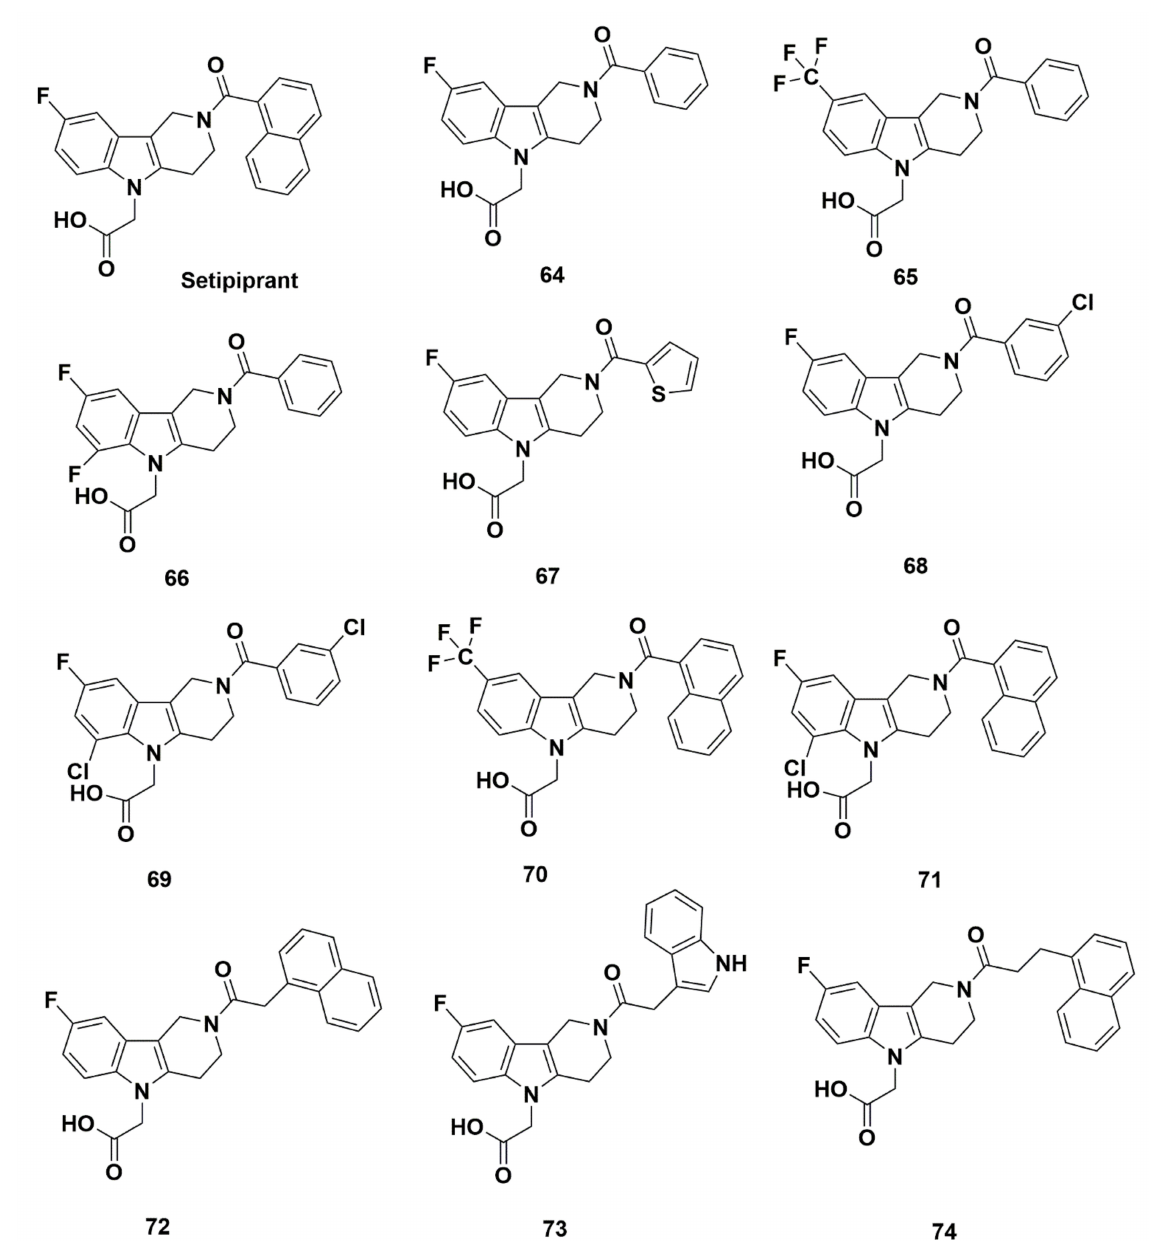
Figure 15. Molecular structures of setipiprant and compounds 64 – 74